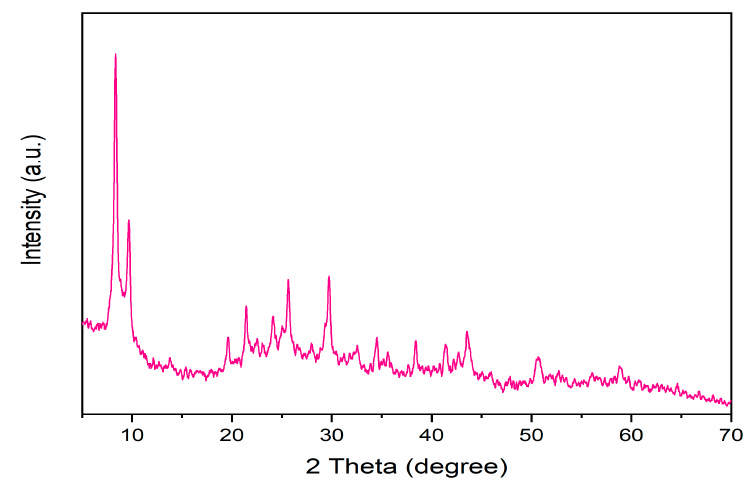
Figure 1. PXRD diffraction patterns of dry and soaked prepared Bio-MOF (MIP-202).